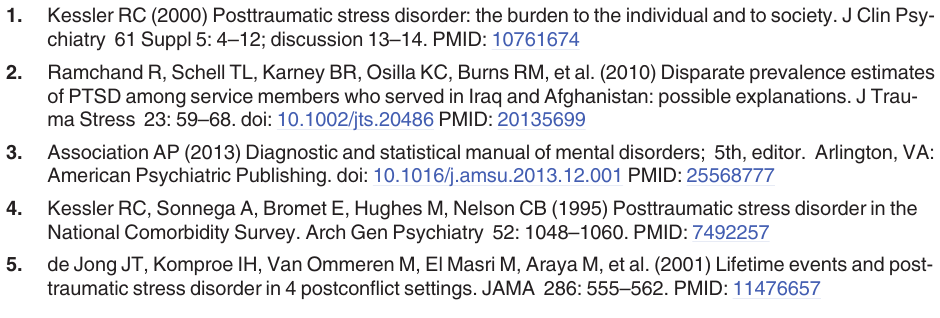
S3 Fig. Validation of gene expression changes observed in microarray experiments.